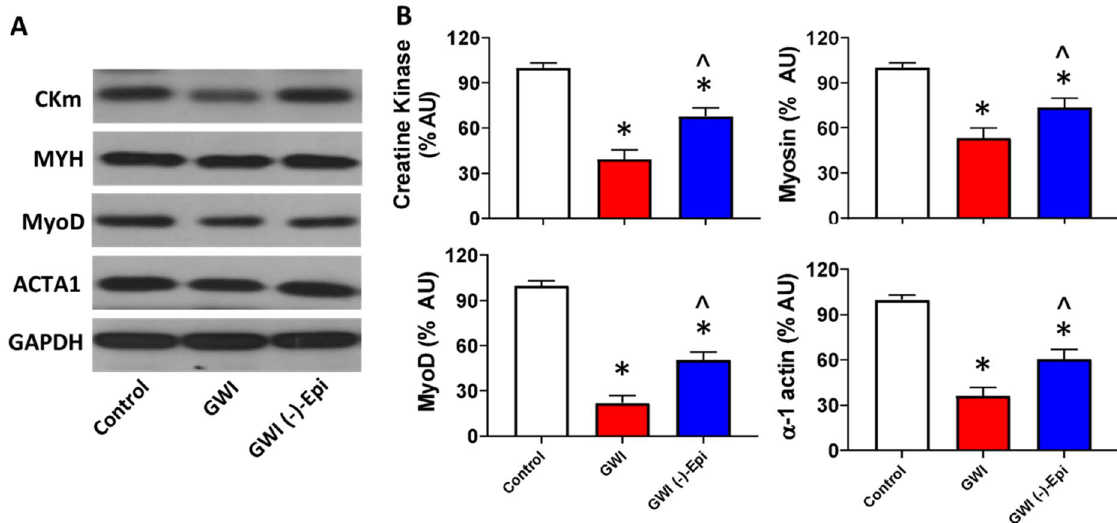
Figure 8. Restorative effects of (−)-epicatechin (Epi) on GWI muscle constitutive proteins. (A) Illustrates a representative image of Western blots and (B) reports on relative changes in protein levels of gastrocnemius muscle creatine kinase, myosin heavy chain 2a, MyoD, and α1-actin in control, GWI and GWI-Epi animals (n = 6/group). *p < 0.05 vs. control, ^p < 0.05 vs. GWI by t-test. AU arbitrary units.